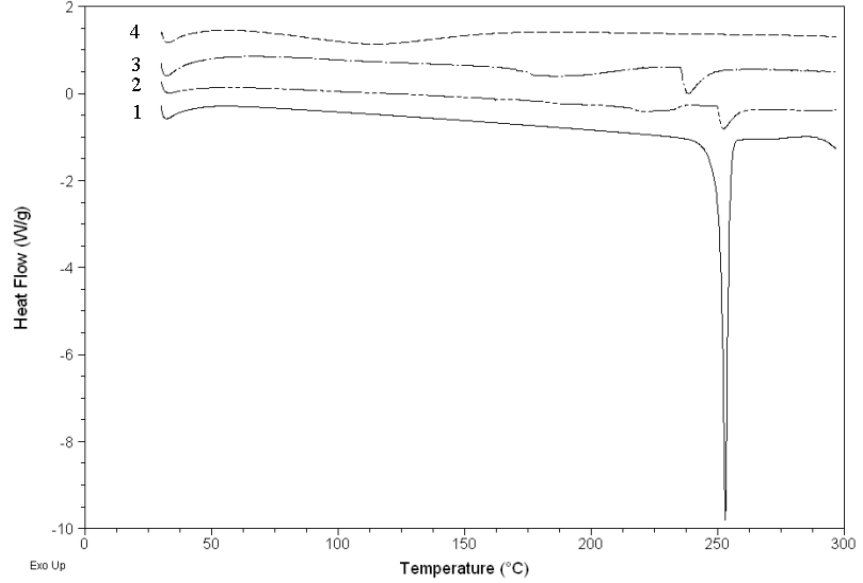
Figure 5. DSC curves of naringenin ( 1 ), physical mixture of naringenin and HP- β -CD ( 2 ), HP- β -CD ( 3 ) and complex of naringenin and HP- β -CD ( 4